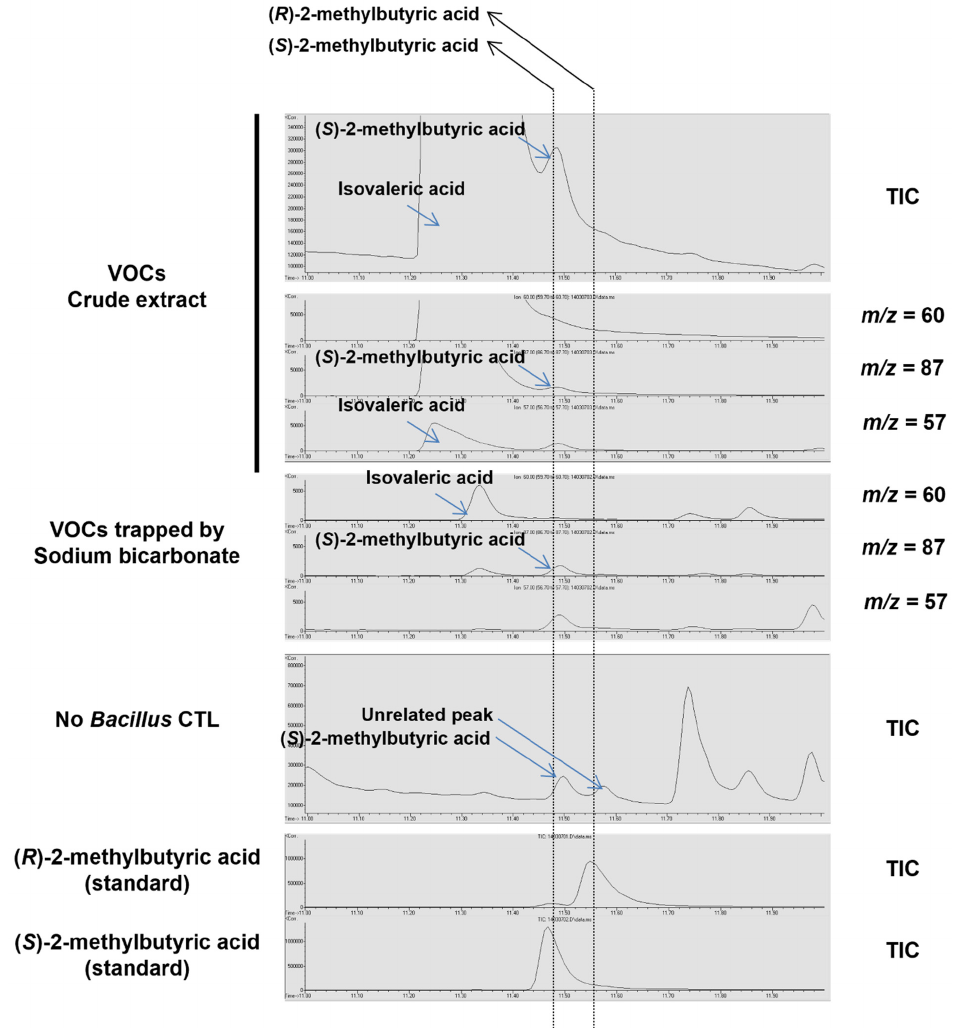
Figure A5. Chiral GC–MS analysis on VOCs from the fraction exhibiting plant growth-inhibiting activity of the ODS column chromatography. The crude extract of Bacillus -derived VOCs and Bacil-